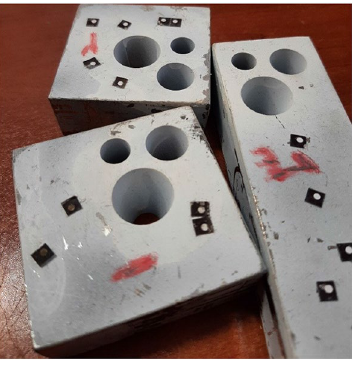
Fig. 6 Fabricated specimens by wire-cut EDM and ready for analyze